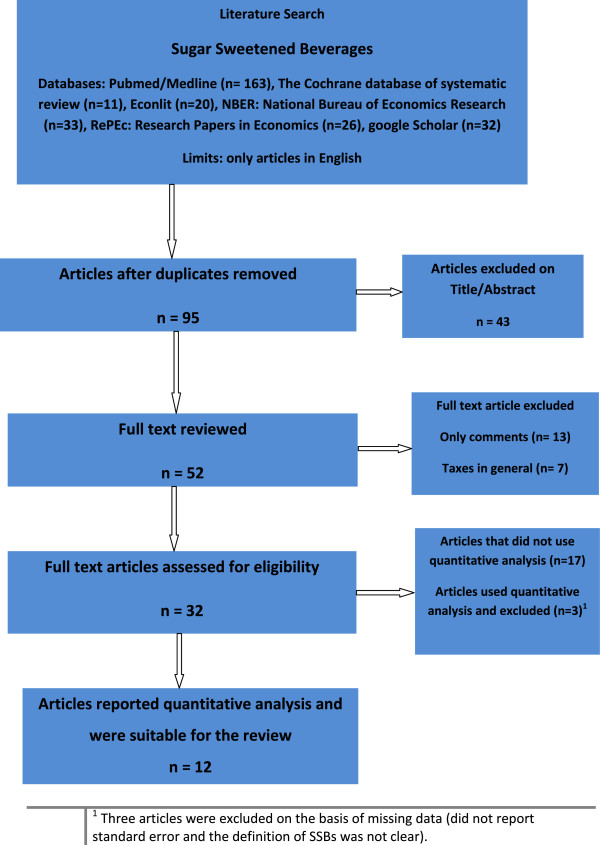
Literature search.